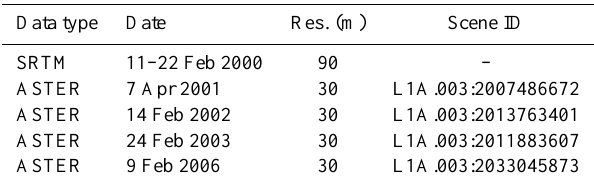
Table 1. New Zealand elevation data type, date acquisition, resolu- tion, and scene